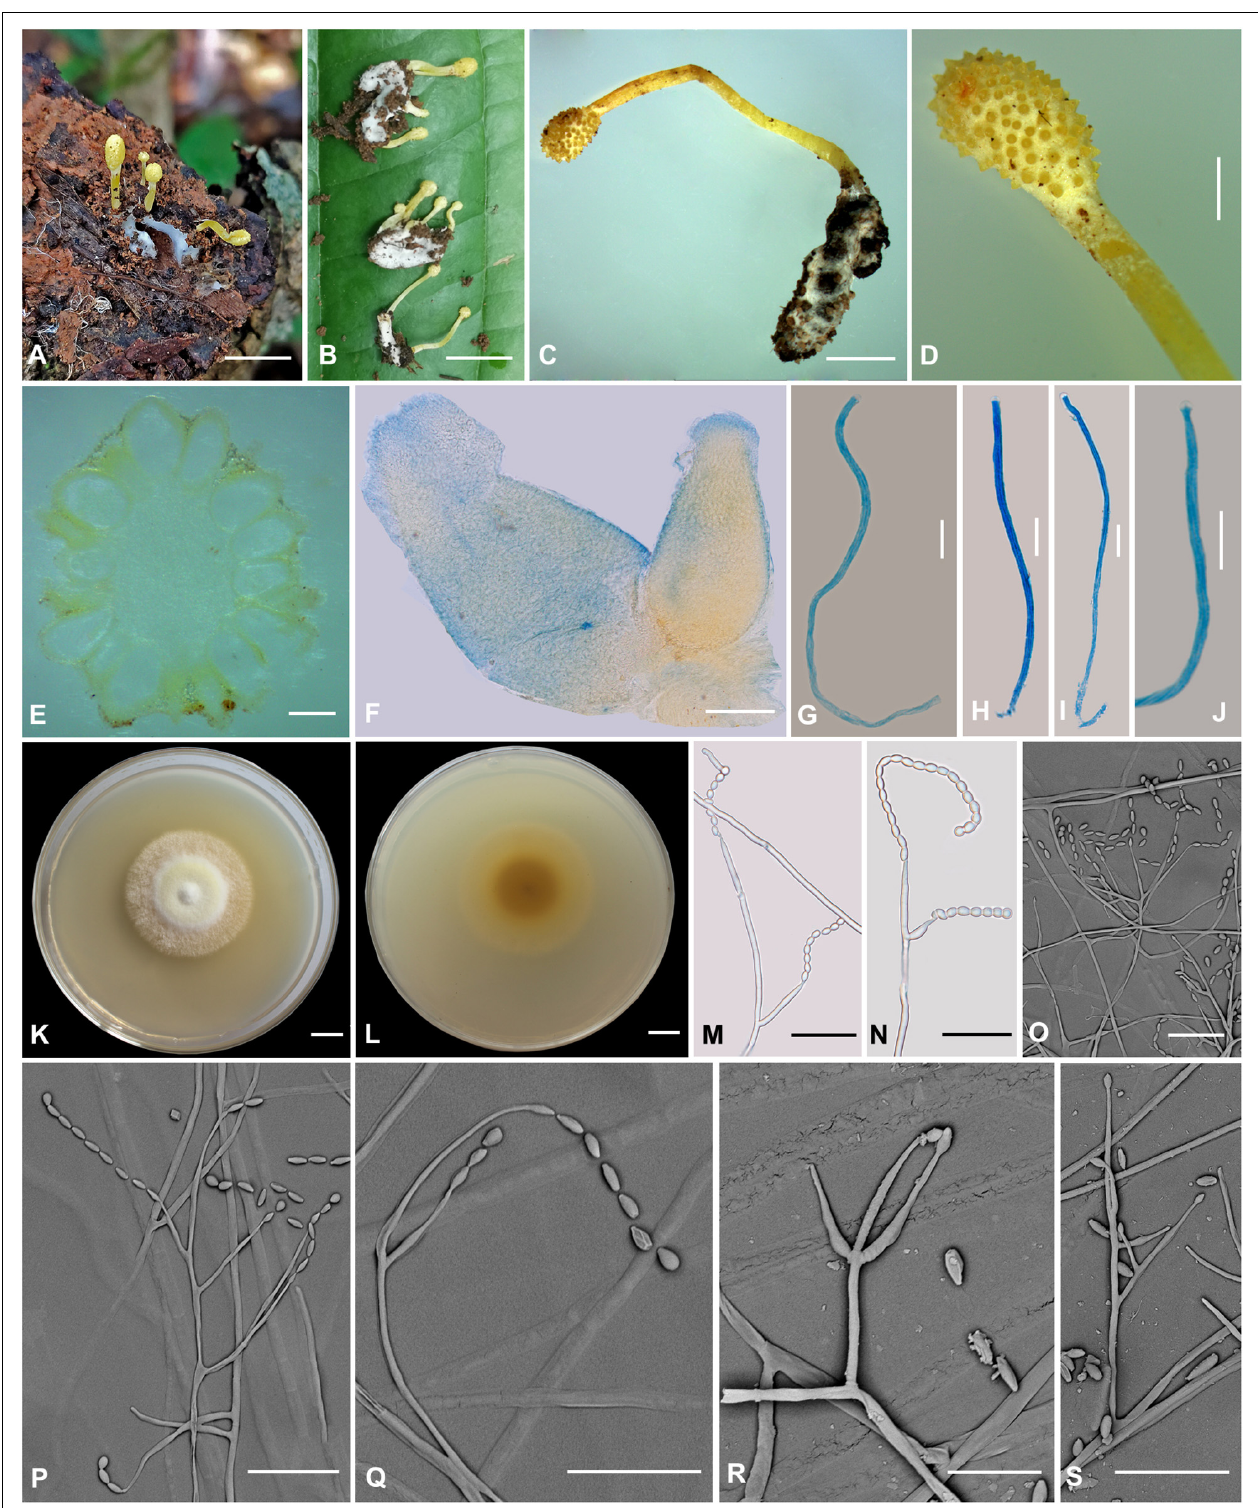
FIGURE 6 | Cordyceps simaoensis . (A–C) Fungus on the host of Lepidoptera. (D) Fertile part. (E,F) Perithecia. (G–J) Asci. (K,L) Colony obverse (K) and reverse (L) on PDA at 21 days. (M–S) Conidiophore and phialide. Scale bars: (A,B) = 10 mm; (C) = 5 mm; (D) = 2 mm; (E) = 400 µ m; (F) = 100 µ m; (G–J) = 10 µ m; (K,L) = 10 mm; (M–S) = 20 µ